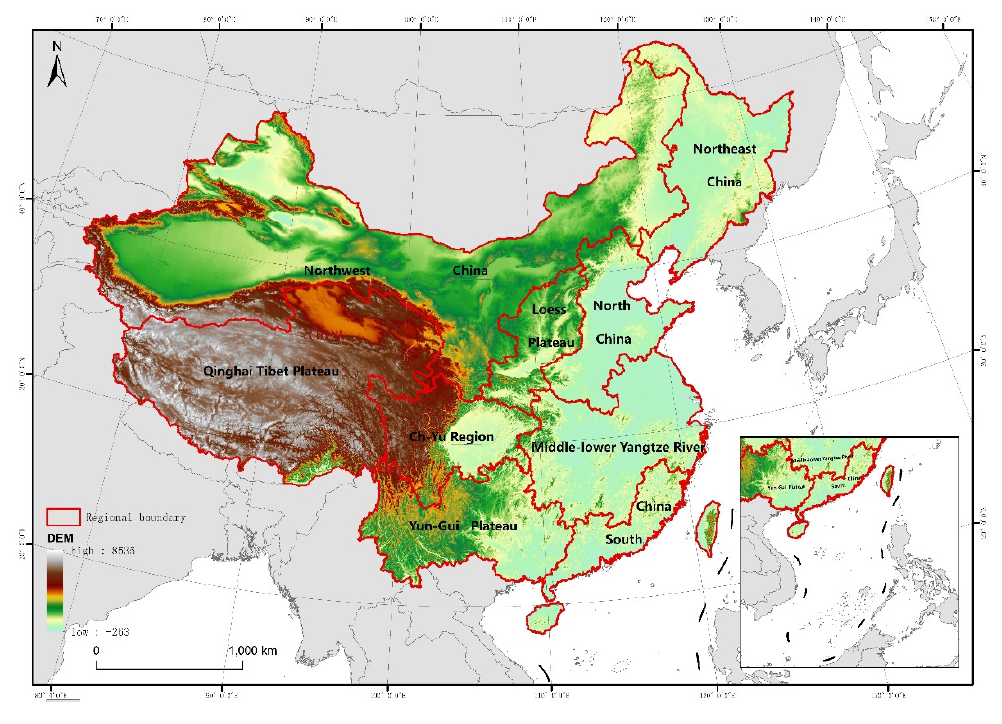
Figure 1. Study area.